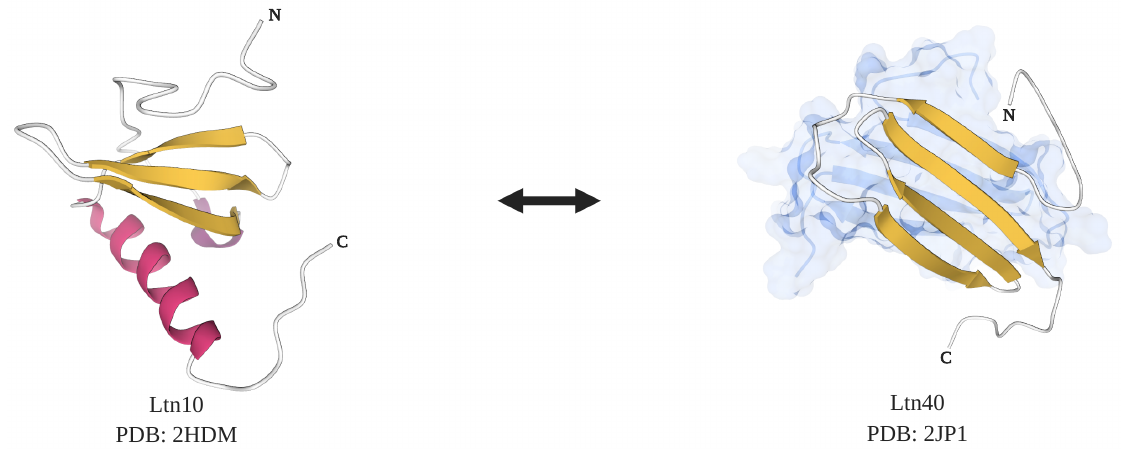
Figure 3. Structures of lymphotactin, a metamorphic protein that is also a moonlighting protein. There are two tertiary folds for lymphotactin, Ltn10 and Ltn40. Ltn10 has a classical chemokine fold with a mix of alpha-helix and beta-sheet (PDB ID: 2HDM [134]). Ltn40 possesses a dimeric form with each subunit composed of mainly beta-sheets (PDB ID: 2JP1 [125]). Note: This figure was “Created with BioRender.com”, and the visualizations of the protein structures were created with Mol* [36] on the RCSB PDB website (rcsb.org)